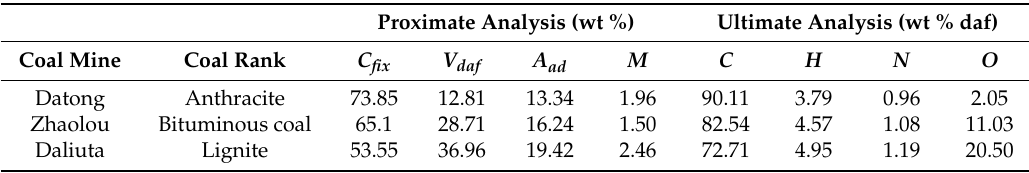
Table 2. Proximate and ultimate analyzes of the coal samples.